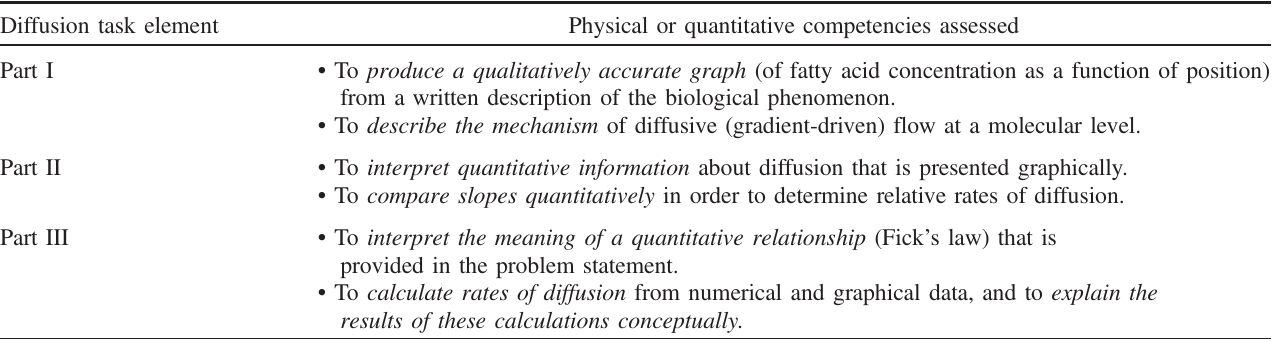
TABLE I. The physical or quantitative competencies assessed in each part of the diffusion task. The full task is provided as Supplemental Material [34]. Diffusion task element Physical or quantitative competencies